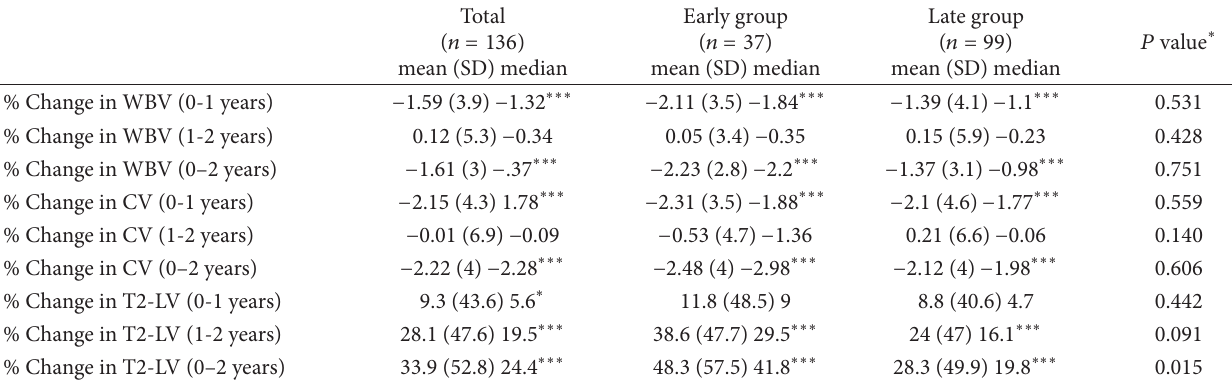
T 2: Changes in MRI outcomes over 2 years between different study